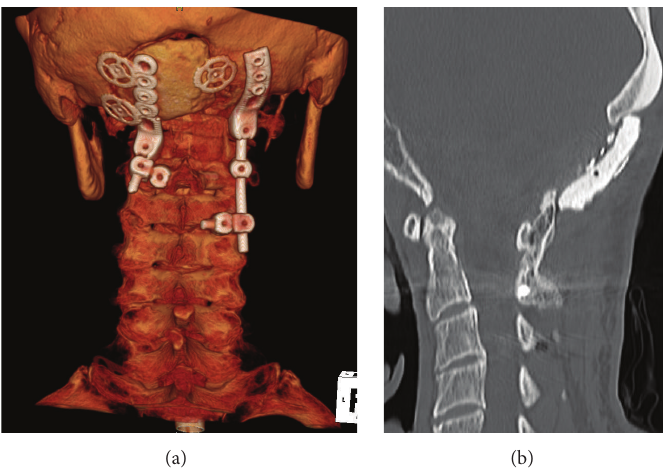
Figure 4: Clinical findings 50 months after surgery. Obvious implant breakage was not observed during a 5-year postoperative follow-up (a). The grafted bone was fused from the occipital bone through the C1 vertebra to the spinous process and the vertebral arch of the C2 vertebra